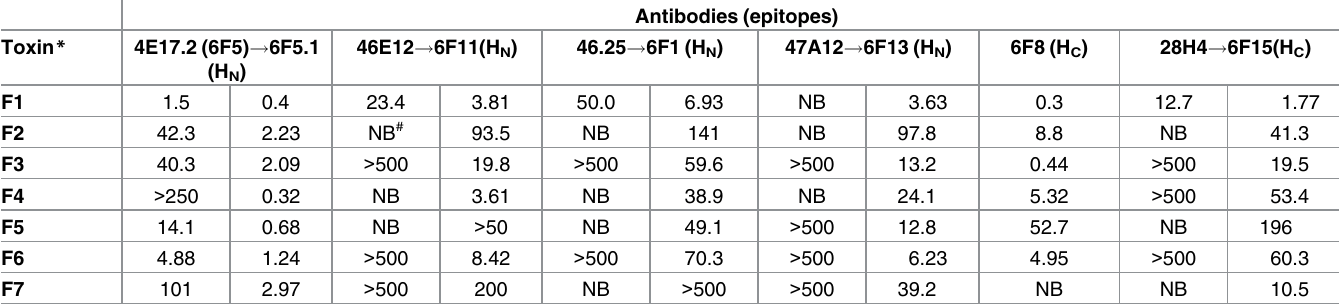
Table 2. The K D values (x 10 -9 M) of affinity and specificity-matured yeast-displayed scFv for the seven BoNT/F